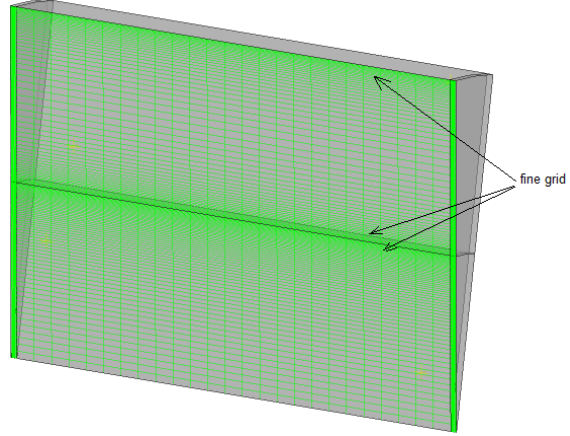
Figure 3. Computational mesh with densification areas at the walls.